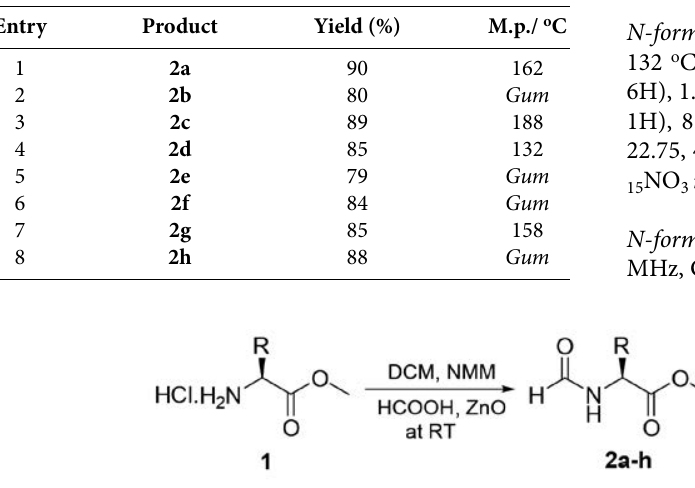
Scheme 1. Synthesis of N -formamide